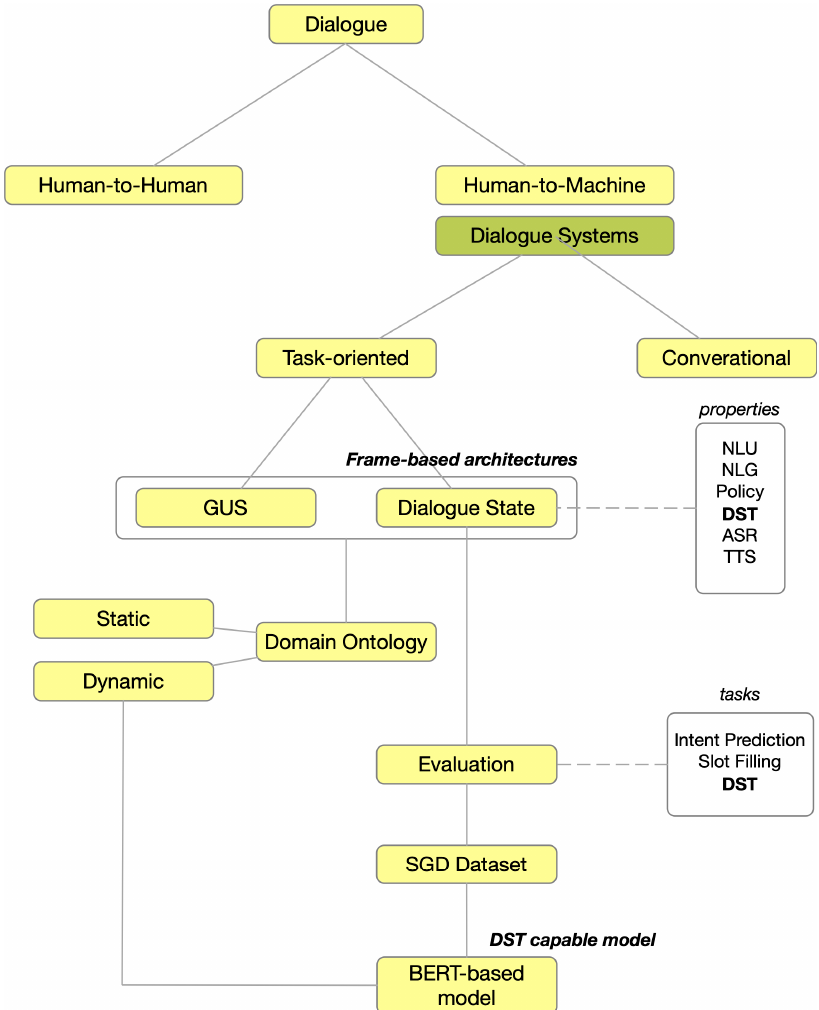
Figure 3. Dialogue System concepts related to CSE a tt ack.